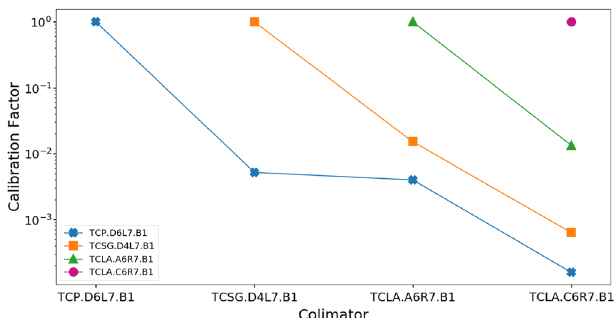
FIG. 7. The cross-talk factors quantifying the effect of each collimator on the downstream collimators, for the set of colli- mators used in the vertical plane in beam 1 (case B1V-1, 1, 0.005, 0.004, 0.00016; case B1V-2, 1, 0.015, 0.0006; case B1V-3, 1,